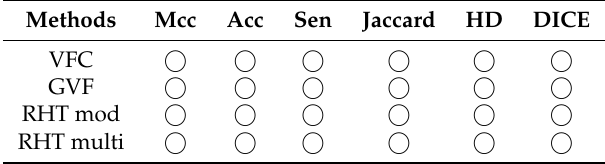
Table 6. Table with the result of Friedman’s non parametric statistical